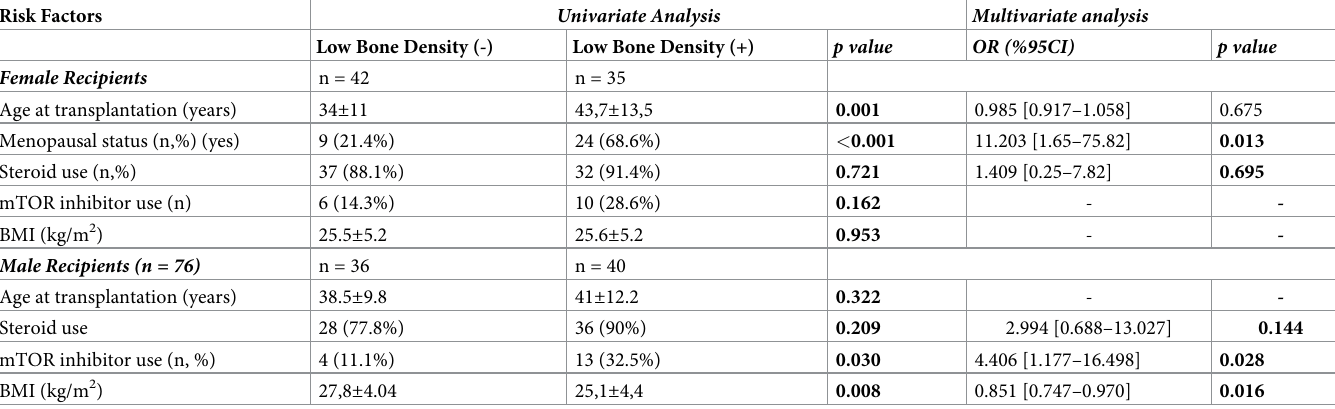
Table 3. Comparison of statistically significant risk factors in patients with and without low bone density with regards to